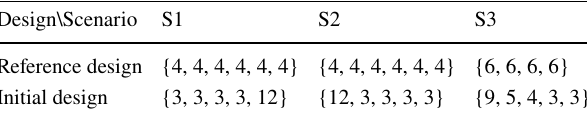
ent operations are distinguished by color; drilling and completion of the same well are colored with the same shade; completion of wells begins after drilling of the whole group has been finished, when the rig has been moved to the next